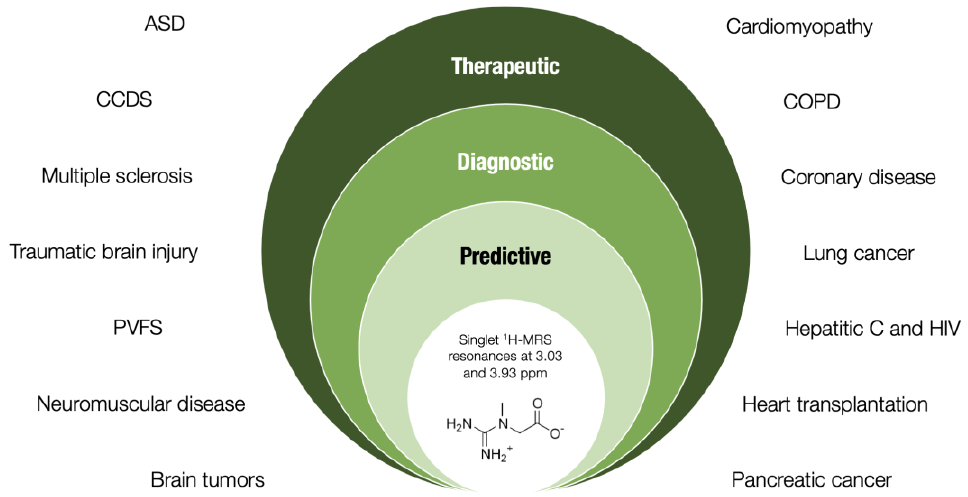
Figure 1. Theoretical framework of tissue creatine assessment via proton magnetic resonance spec- troscopy (MRS) in clinical science. Abbreviations : ASD, autism spectrum disorder; CCDS, cerebral creatine deficiency syndromes; PFVS, post-viral fatigue syndrome; COPD, chronic obstructive pul- monary disease.